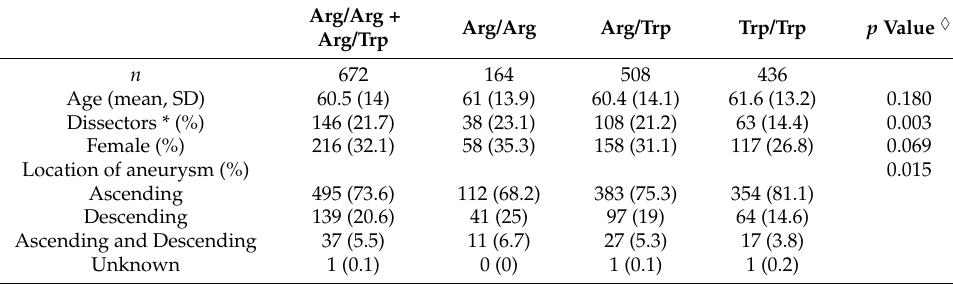
Table 3. Likelihood of dissection (and aneurysm details), by